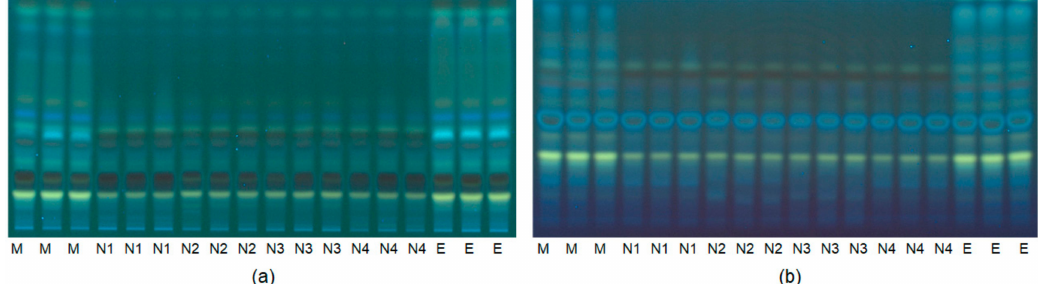
Figure 2. High-performance thin-layer chromatograms (HPTLC) of Scutellaria baicalensis bark extracted with 80% methanol in water, 70% ethanol in water and natural deep eutectic solvents (NADES) visualized at 366 nm after derivatization with natural products reagent (NPR) with two di ff erent mobile phase conditions. ( a ) Chromatogram obtained with the mobile phase: ethyl acetate, methanol, formic acid, water (EMFW, 20:2.7:0.5:2, ratio v / v / v / v ); ( b ) Chromatogram obtained with the mobile phase: ethyl acetate, formic acid, acetic acid and water (EFAW, 100:11:11:27, v / v / v / v ). M: 80% methanol in water extract ( v / v ), E: 70% ethanol in water (v / v), N1–N4: NADES with the addition of 10% water ( w / w ).